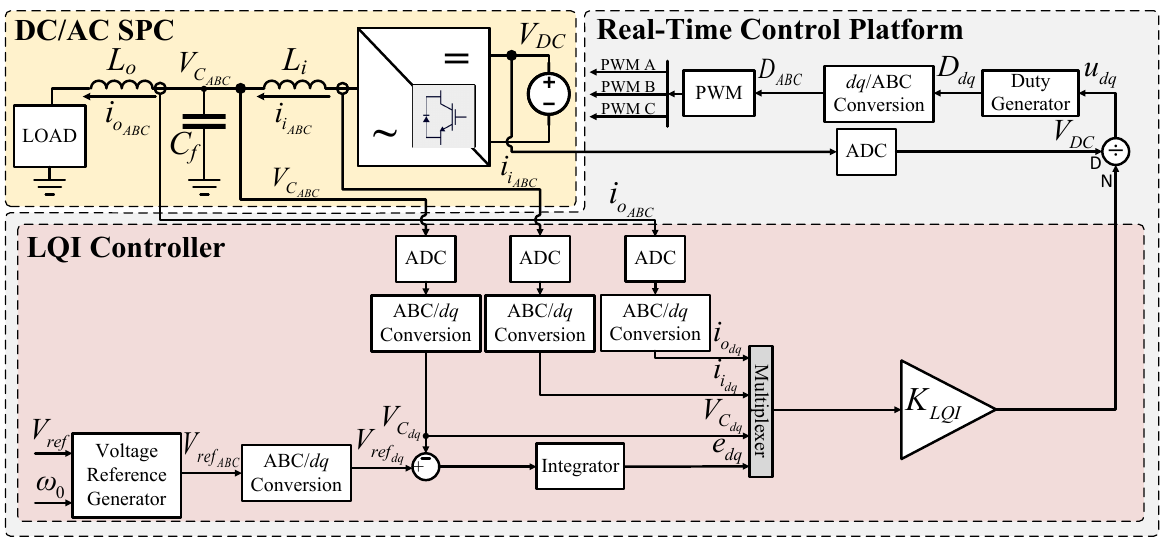
Figure 7. General structure of the LQI controller for DC/AC SPC.